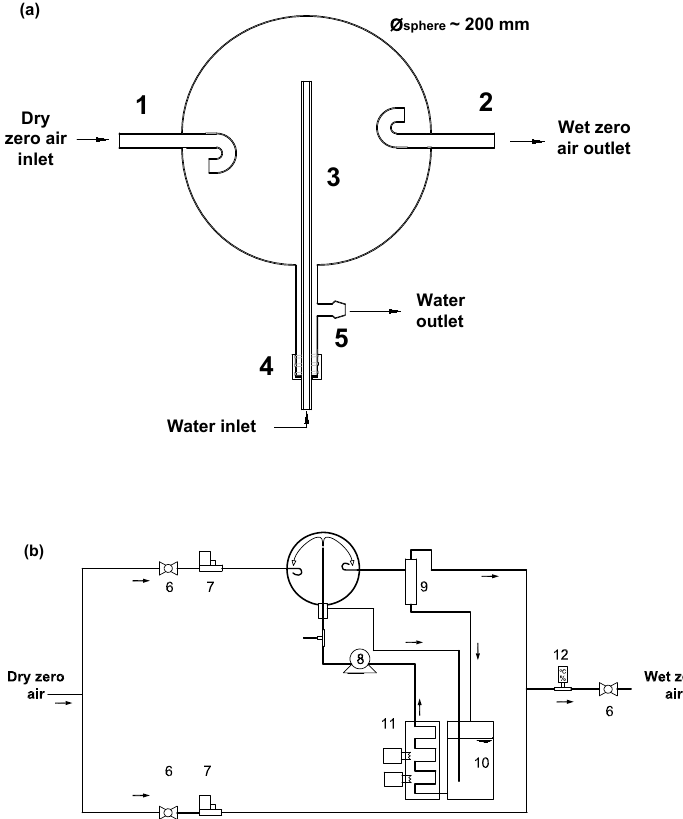
Figure 1. Schematic of the (a) humidifier and (b) the elements that comprise the humidifying system used in this work. (1) Dry zero air inlet; (2) wet zero air outlet; (3) and (4) water inlet; (5) water outlet; (6) shut-off valves; (7) mass flow controllers; (8) water pump; (9) cyclone; (10) water container; (11) thermostatic bath; (12) thermohygrometer.